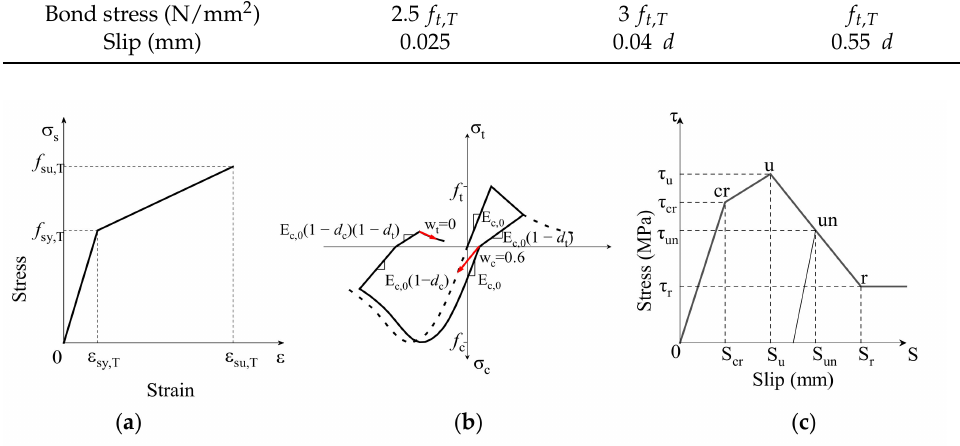
Table 1. Bond stress-slip constitutive of concrete and reinforcing steel at ambient temperature. Feature Point Crack Point ( cr )